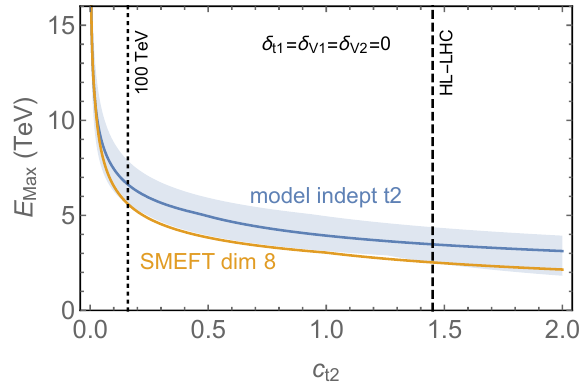
Figure 16 . The unitarity bounds from both the model-independent approach and the SMEFT dimension-8 prediction, the optimized bound from marginalizing over other couplings should be somewhere between these two lines. We assume δ 95% C.L. limits on the coupling from the gluon fusion di-Higgs analysis at the HL-LHC and a 100 TeV pp collider [36].